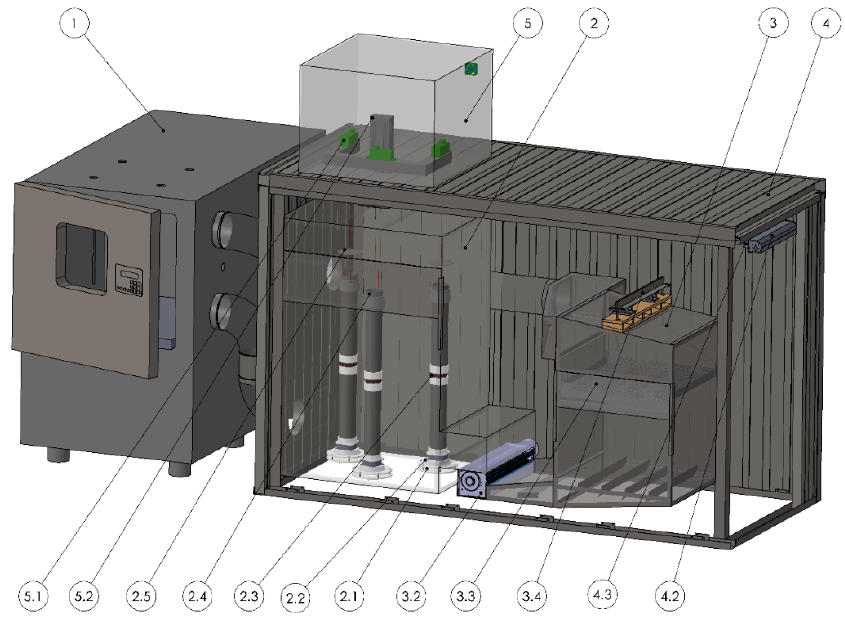
Figure 2. 3D model of the high-precision laboratory dryer HPD TP3+; 3D image with numbered subsystems (for legend, see Table 2).